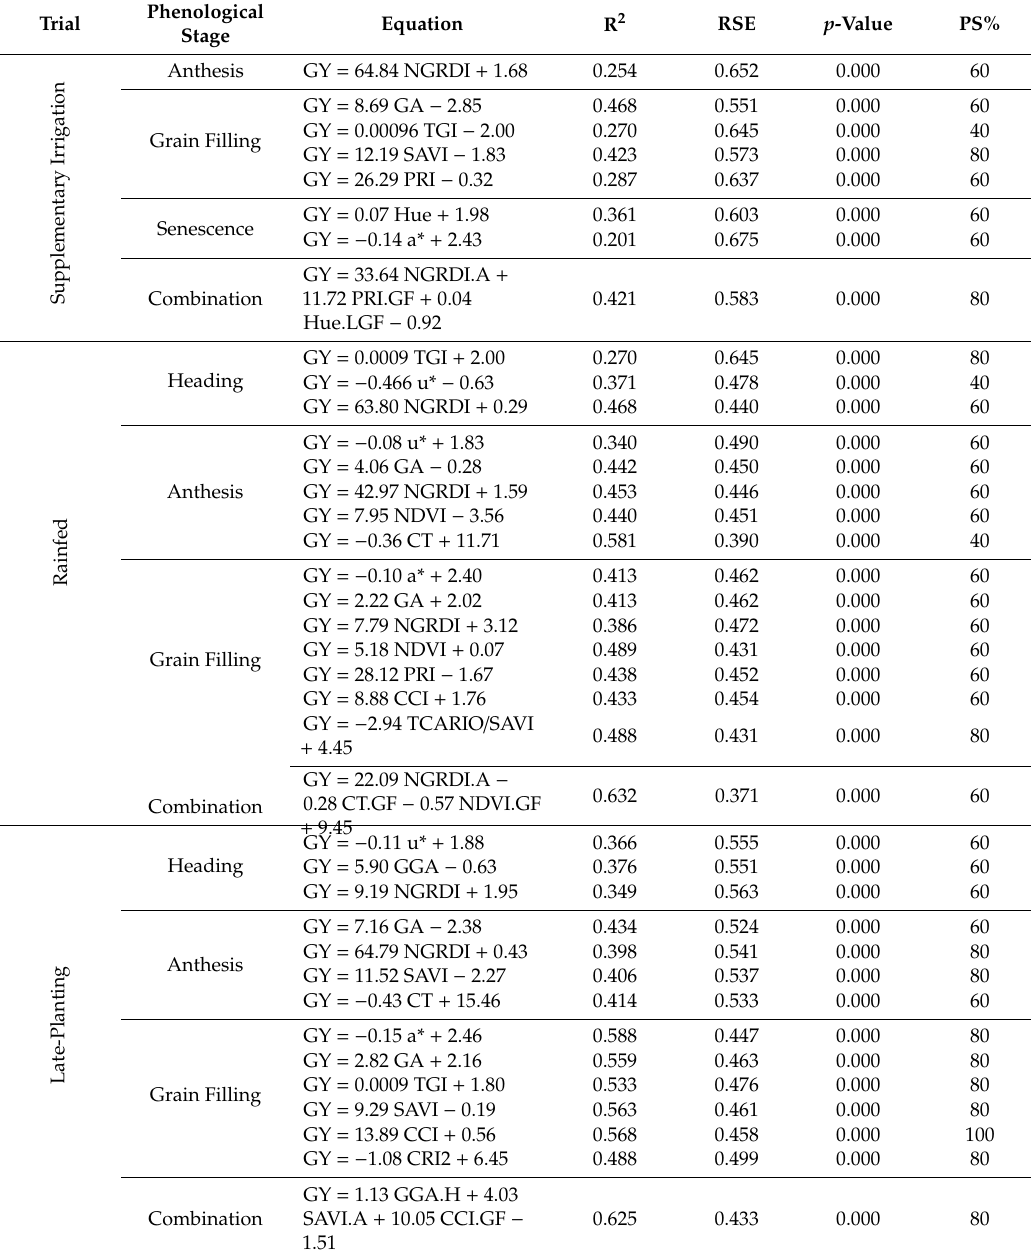
Table 6. Multilinear regression (stepwise) of grain yield (GY) as a dependent variable and the remote sensing traits (RGB and multispectral indexes and the thermal measurements) measured both from the ground and aerially as independent variables. Regressions were studied across plots (n = 72) within each growing condition (supplementary irrigation, rainfed, and late-planting). The strength in the prediction of the five highest-yielding cultivars was determined (PS%). R 2 , determination coe ffi cient; RSE, residual standard error; A, anthesis; GF, grain filling; LGF, late grain filling; H,